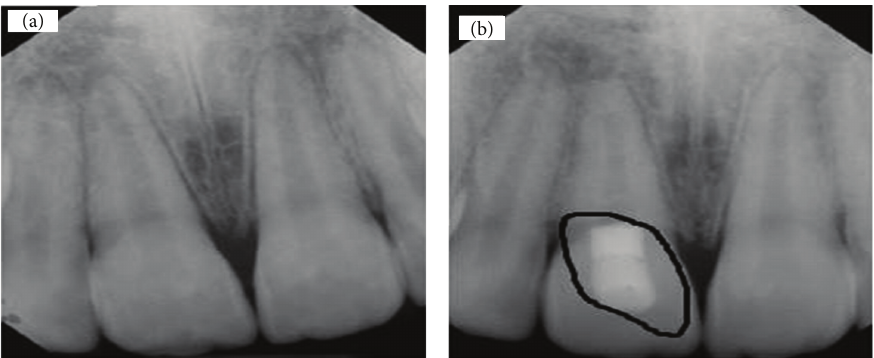
Figure 2: Detection of dental caries and restoration by dentist: (a) safe, (b)